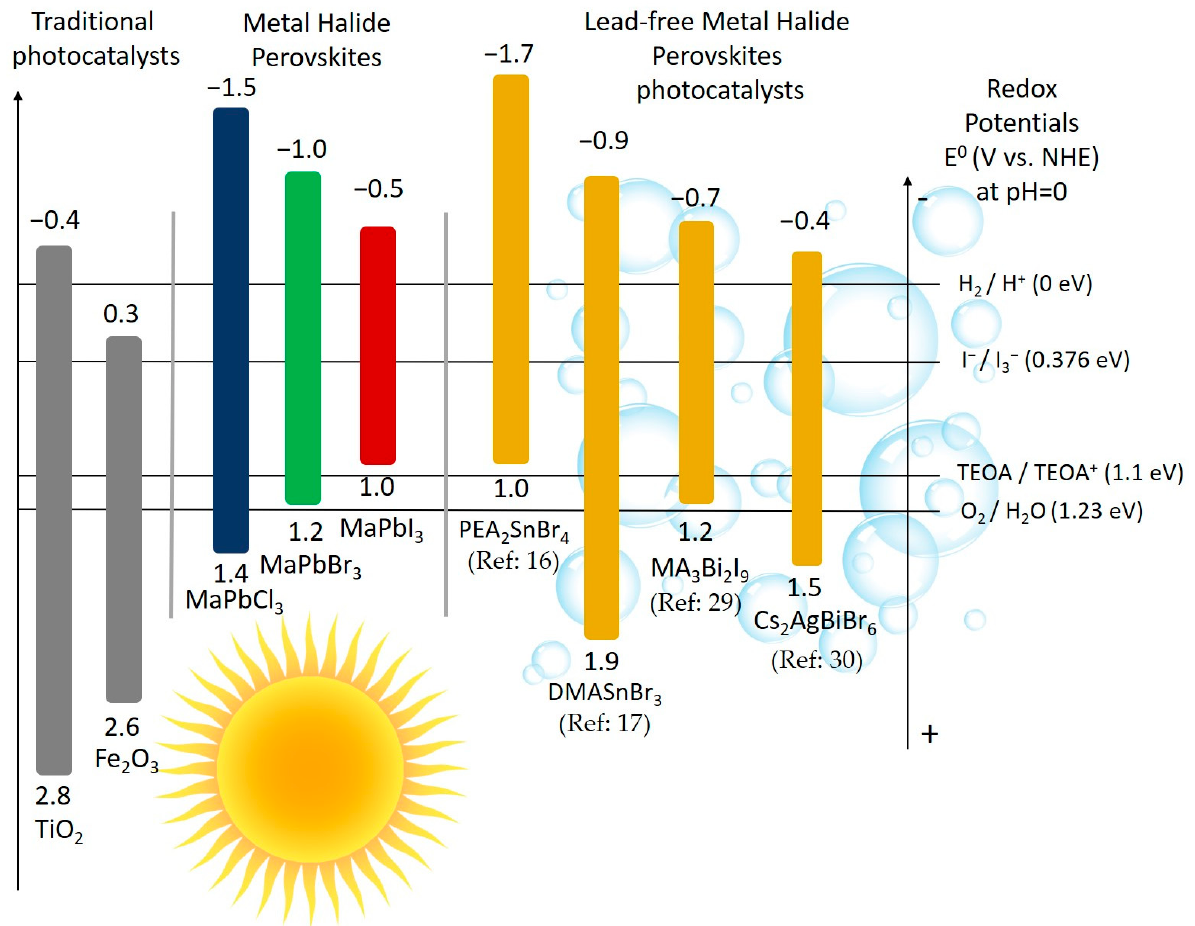
Figure 3. Redox potentials of TiO 2 and Fe 2 O 3 taken as example of traditional photocatalysts, Pb-based halide perovskites and Pb-free MHPs already exploited for hydrogen evolution processes.